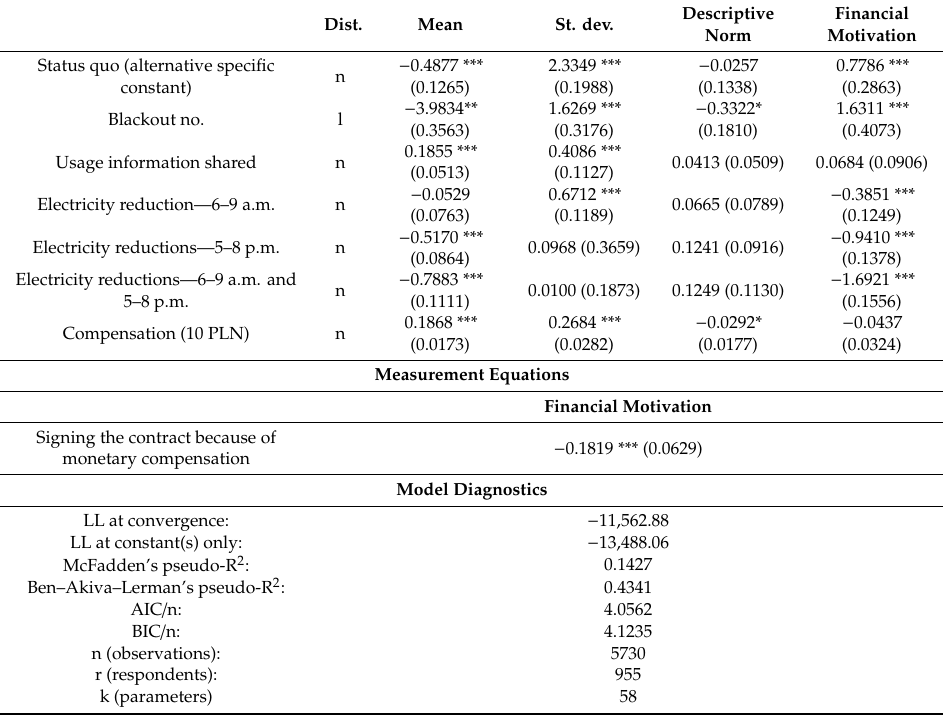
Table 6. The results of the hybrid choice model linking respondent descriptive social norms perceptions and financial motivation with their economic preferences for electricity supply